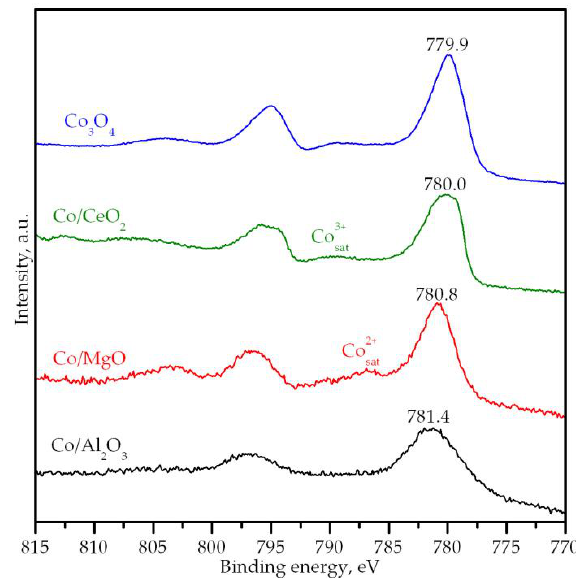
Figure 4. X-ray photoelectron spectroscopy (XPS) spectra of the supported cobalt catalysts.